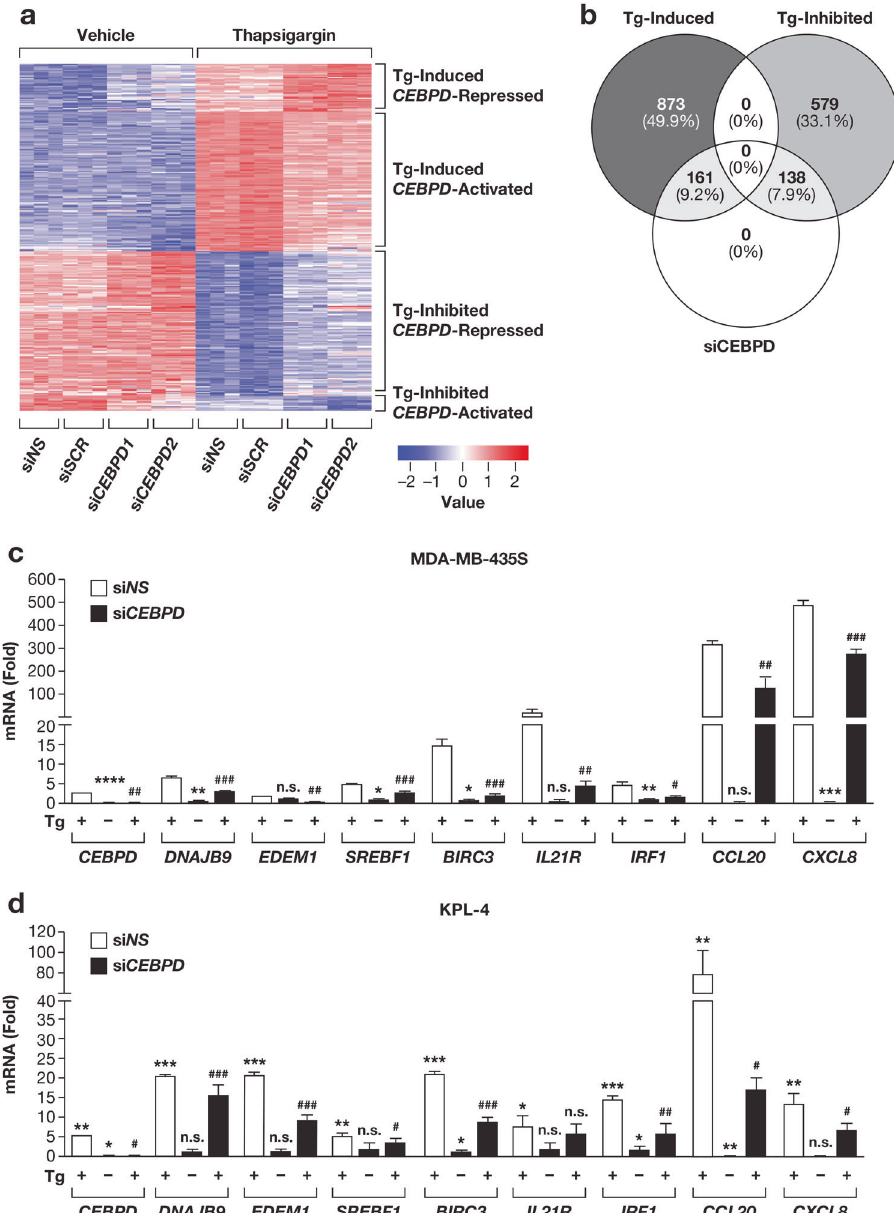
Fig. 4 C/EBP δ mediates ER stress-induced changes in gene expression. a Heatmap of differentially expressed genes (DEGs) as determined by mRNA-Seq of MDA-MB-435S cells transfected with either of two independent controls (NS, SCR) or two independent CEBPD -targeting siRNAs (CEBPD1, CEBPD2) treated with vehicle or 100 nM Tg for 6 h. Only genes that were signi fi cantly altered by Tg-treatment in control siRNA transfected cells were included in this analysis, b Venn diagram illustrating the number of DEGS shown in a . c qRT-PCR analysis of select genes from a in siCEBPD1 transfected cells relative to DMSO-treated siNS control of cells treated as in a . d qRT-PCR analysis of the indicated genes in KPL-4 cells after transfection with siNS control or siCEBPD1 + 2 and treated with DMSO or Tg (100 nM) for 6 h, relative to DMSO treated control. Quantitative data are represented as mean±S.E.M, n = 3; * P < 0.05, ** P < 0.01, *** P < 0.001, **** P < 0.0001 for comparisons to siNS treated with *DMSO or #Tg; n.s., not signi fi